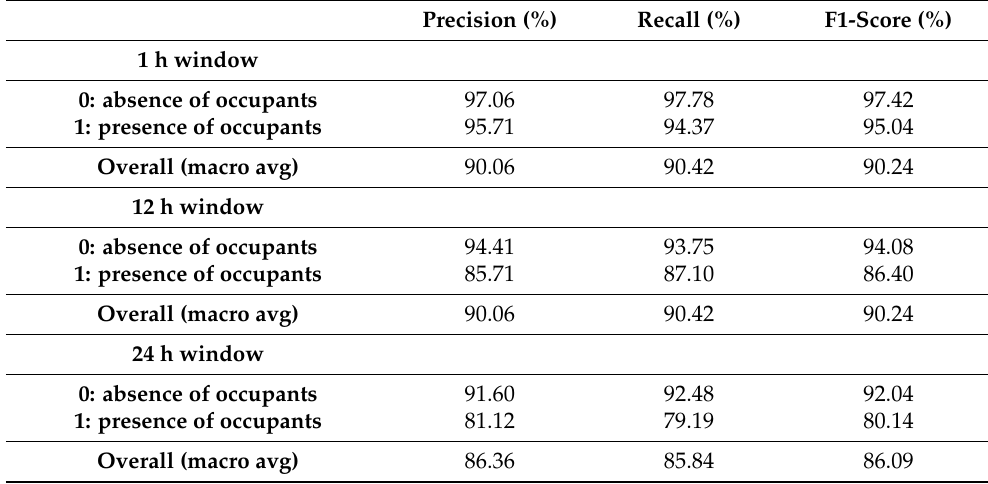
Table 2. Binary prediction